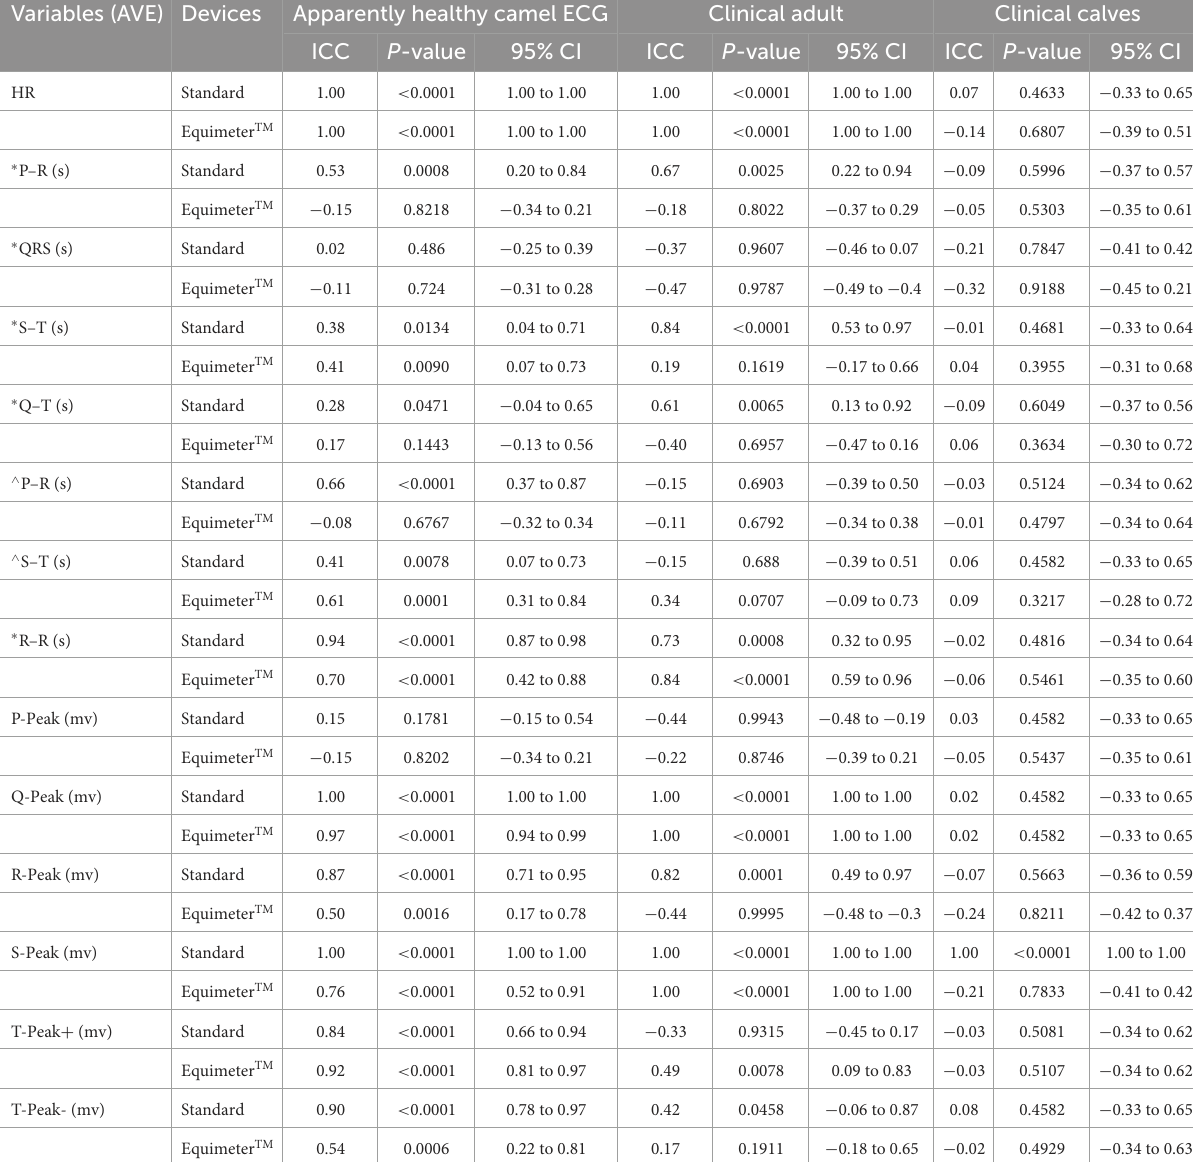
TABLE 4 Intraclass correlation coefficient (ICC) between examiners and each device for each category. Variables (AVE) Devices Apparently healthy camel ECG Clinical adult Clinical